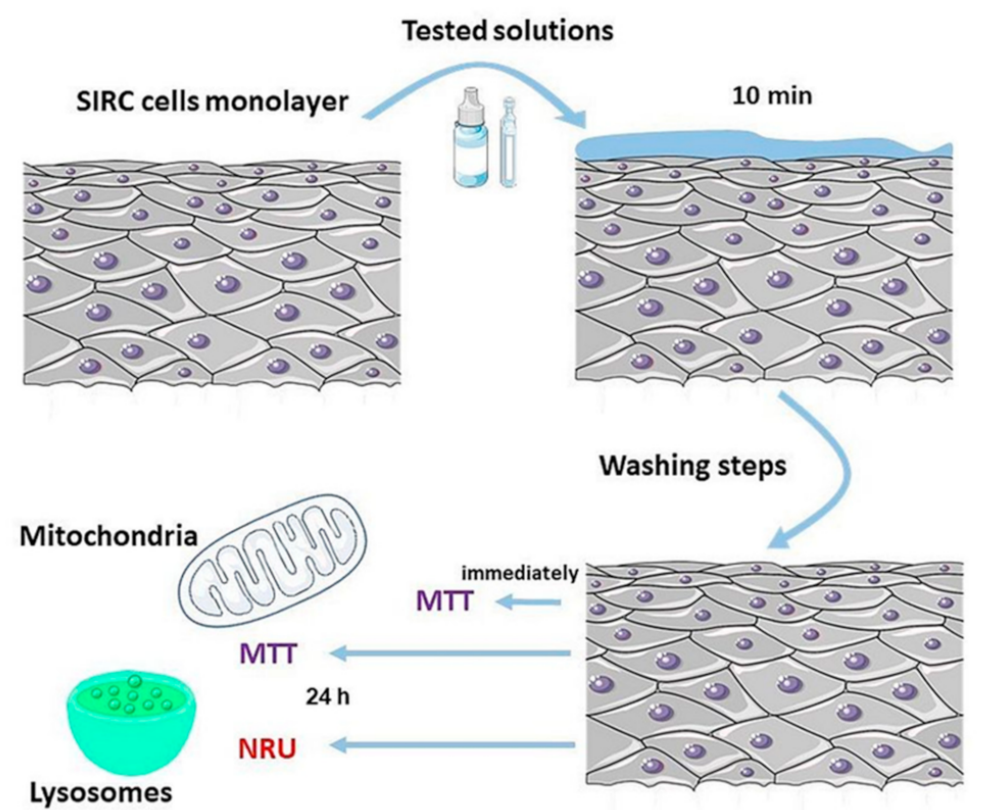
Figure 9. A schematic illustration of the in vitro experiments using the SIRC cell line. The impact of tested eye drops on cell viability was determined using MTT and NRU